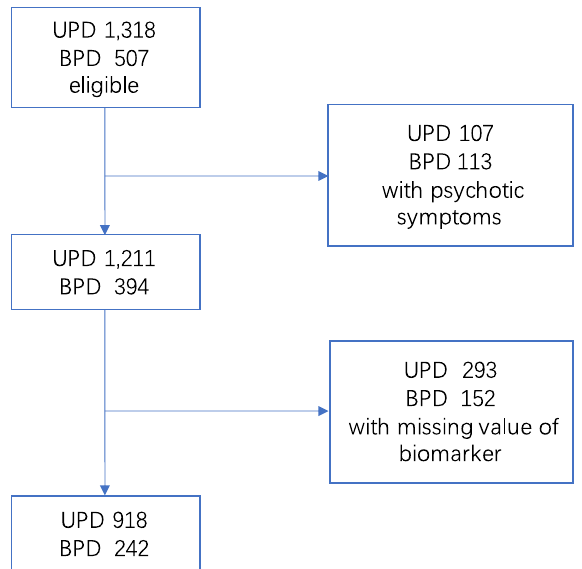
Fig. 1 Flow of participants in the study. Patients with psychotic symptoms and missing values of biomarkers were excluded from the participants. As a result, a total of 921 UPD patients and 239 BPD patients participated in the